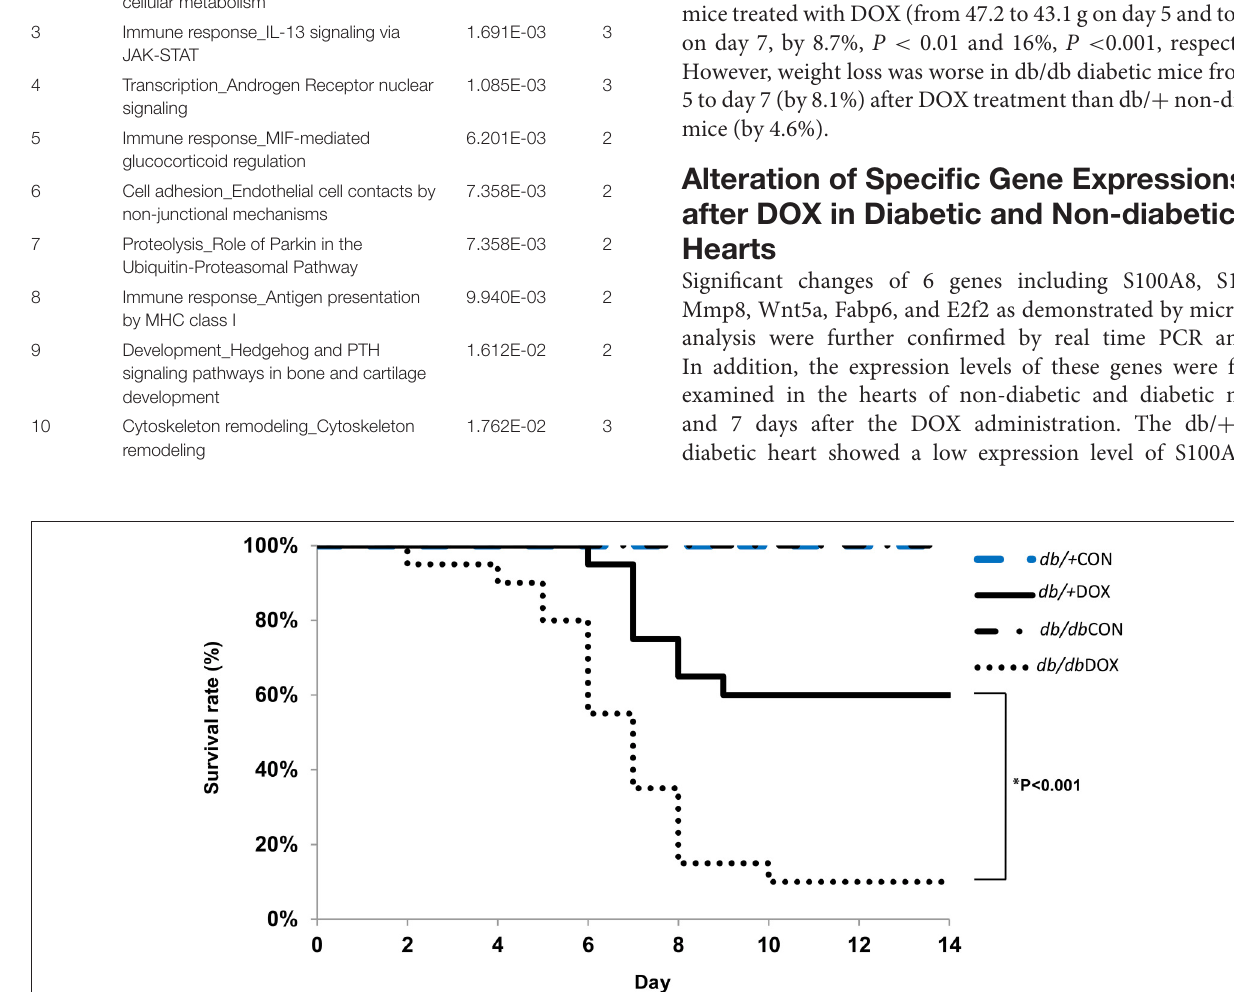
FIGURE 1 | Animal survival analysis. Decreased survival rate in db/ + DOX (non-diabetic mice treated with DOX, n = 20 per group), and db/db DOX (diabetic mice treated with DOX, n = 20 per group). * P < 0.001 compared to non-diabetic mice treated with DOX on day 7 and 14.